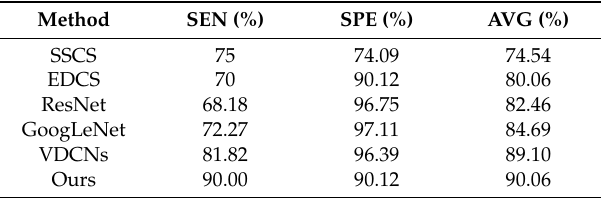
Table 4. Comparison of classification rates on Dataset